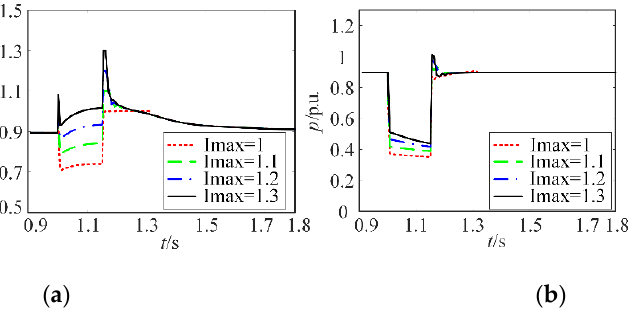
Figure 9. Simulation results in cases (5)–(8) of the fault on location A: ( a ) active current; ( b ) active output. Table 4. Active power index in cases (1)–(8) of the fault on location A. Working Condition